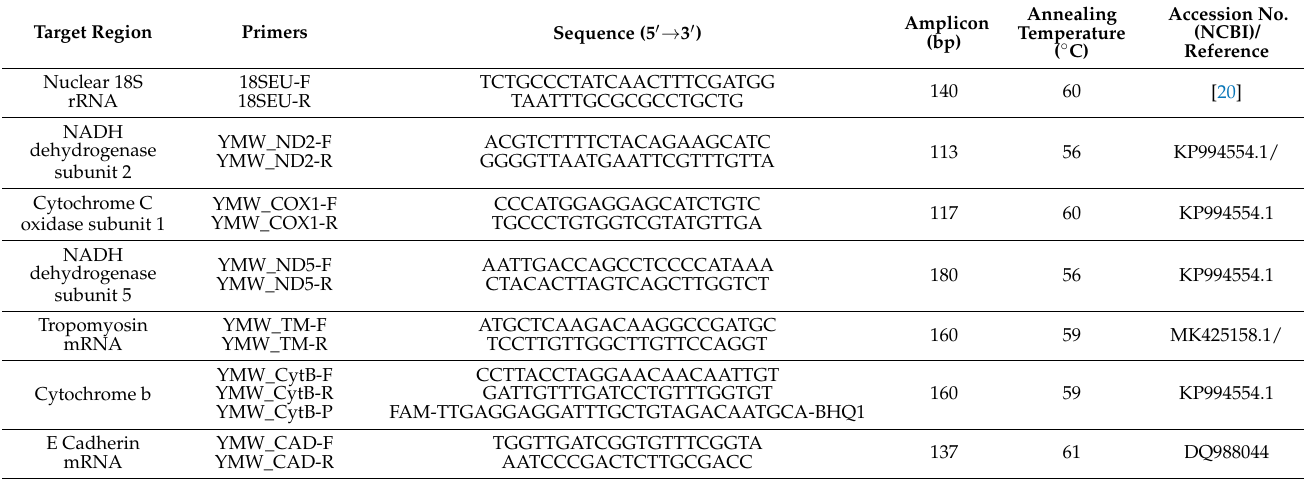
Table 1. Key data of primers and the hydrolysis probe designed for yellow mealworm detection and universal eukaryotic primers targeting a conserved 18S